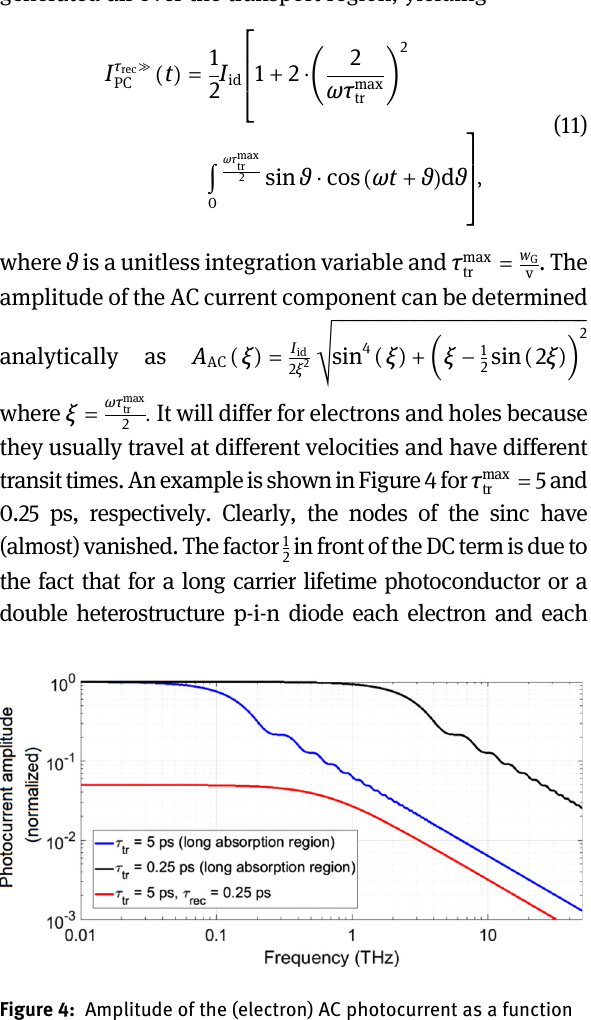
Figure 4: Amplitude of the (electron) AC photocurrent as a function of frequency for three different cases: a long-carrier-lifetime pho- = 5 ps, a long carrier-lifetime photoconductor toconductor with τ max tr = 0 . 25ps,andashort-carrier-lifetime withasub-pstransit-time τ max tr = 5 ps and a τ photoconductor with a long transit time τ max rec = 0.25 tr ps. The amplitudes are normalized to the long lifetime cases. All cases show a f − 1 AC current roll-off, corresponding to a f − 2 power roll-off. The short-carrier-lifetime material has a g = 0 . 05 times lower DC amplitude and a lower 3 dB frequency as the τ tr = 0 . 25 ps long-carrier-lifetime case, but a higher one than the τ tr = 5 ps